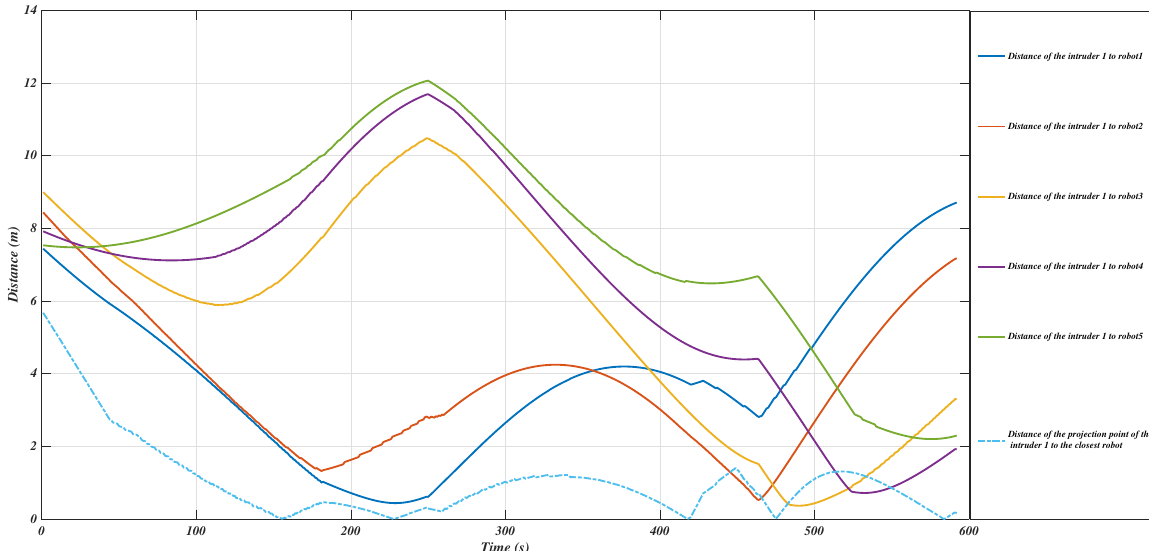
Figure 6. The intruder trajectory and the positions and the motion directions of the USVs when the intruder is at points a 1, a 2, b 1, b 2, c 1, c 2, d 1 and d 2.